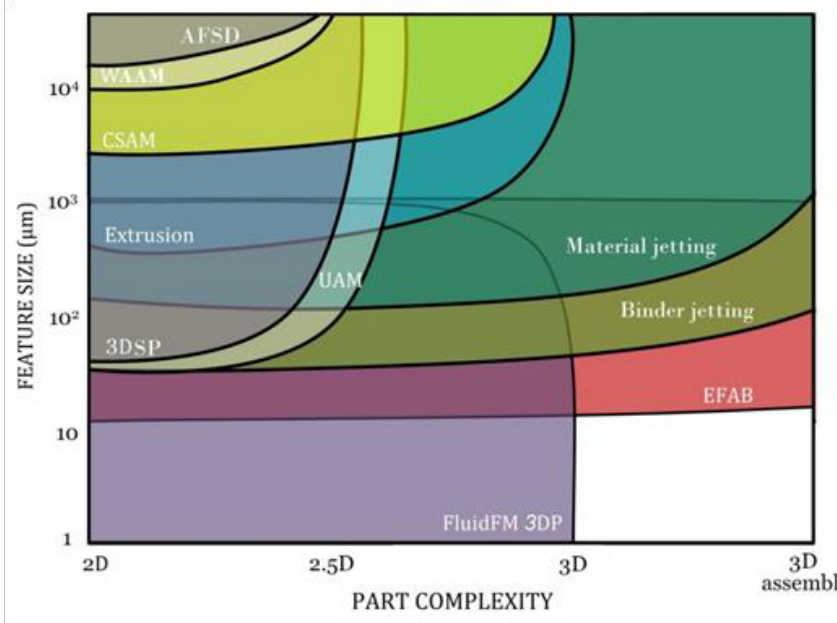
Figure 15. Comparison of the key beamless metal AM systems in terms of part complexity and minimum feature size. Material jetting, binder jetting, and EFAB processes have the capability to print sophisticated 3D parts and assemblies. FluidFM 3DP, extrusion, and CSAM can be used for manufacturing of true 3D parts, while the other processes are normally served for parts with less complexity. Materials 2020 , 13 , x FOR PEER REVIEW